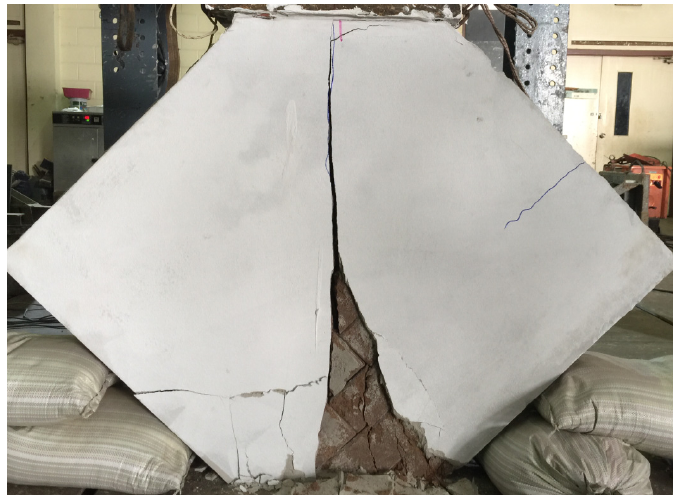
Figure 20. Failure of wall (W-PC1-10).